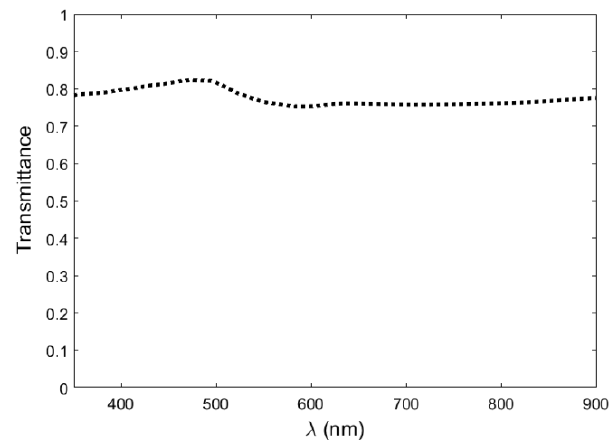
Figure 7. Transmittance of the modelled Au top